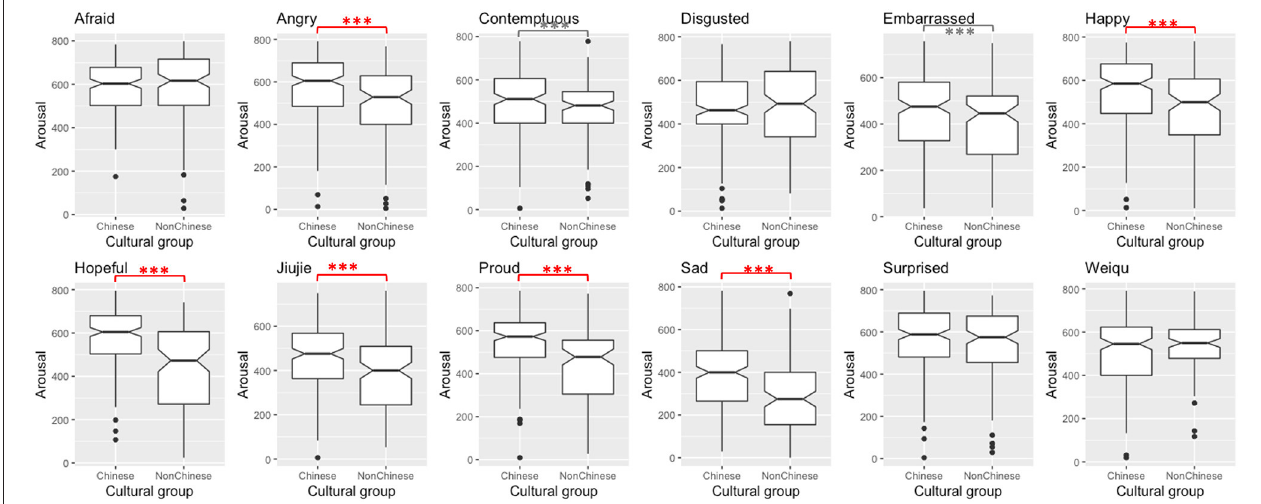
FIGURE 4 | Differences in Chinese and non-Chinese participants’ arousal ratings per stimulus (***Significant at 0.01 level, *Significant at 0.05 level, significant and meaningful differences in red, significant and reaching meaningfulness in dotted red, significant but unmeaningful differences in